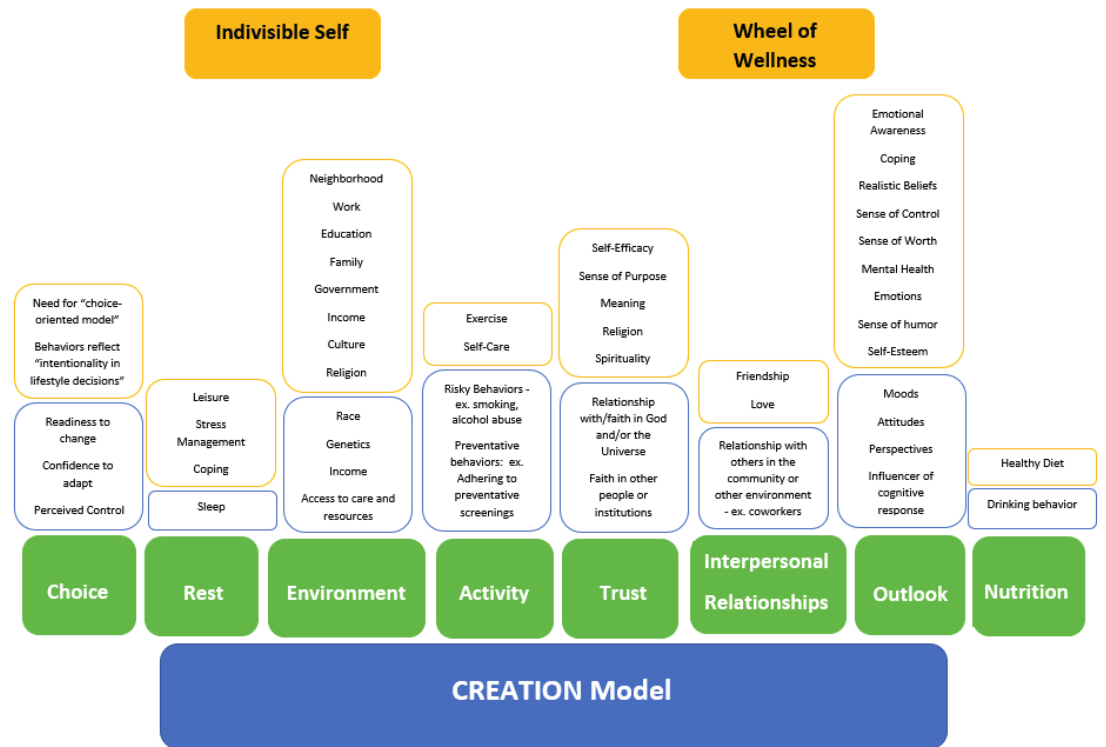
Figure 2. CREATION model constructs and their wellness model influences (in